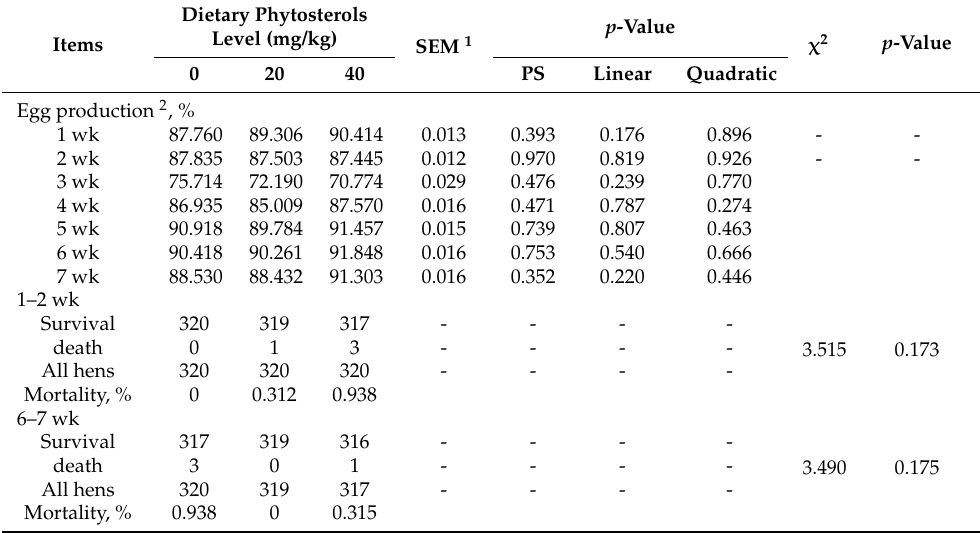
Table 2. Effects of dietary phytosterols on the productive performance in aged laying hens.